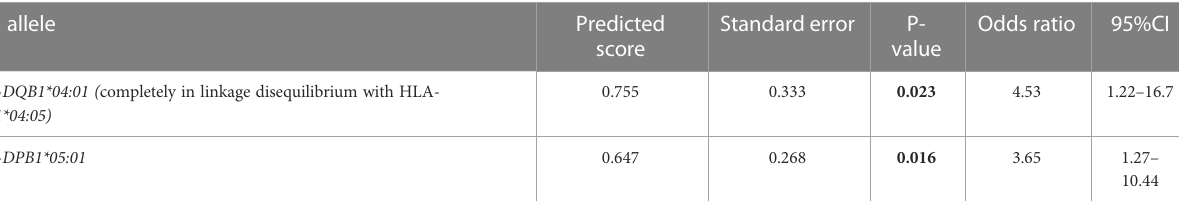
the controls. Moreover, signi fi cant amino acid polymorphisms at to the development of ICI-T1DM, probably with conformational